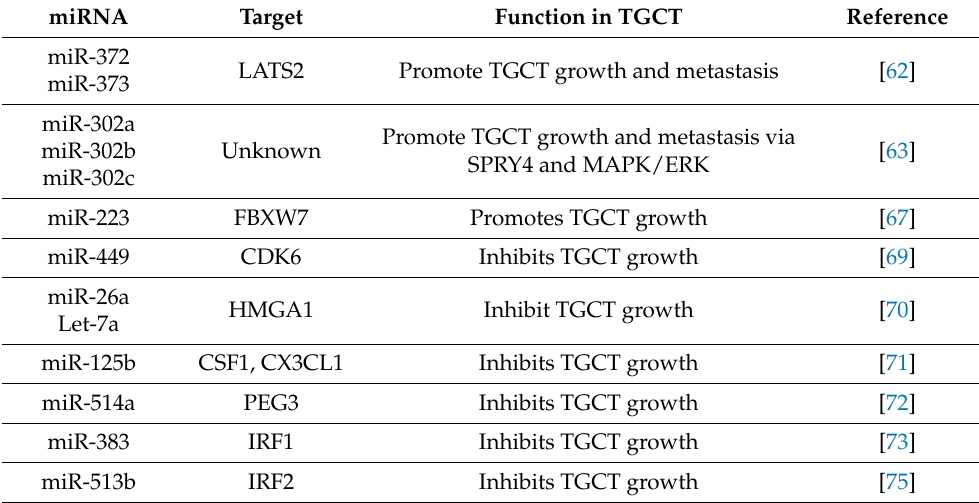
Table 1. Targets and functions of miRNAs involved in TGCT